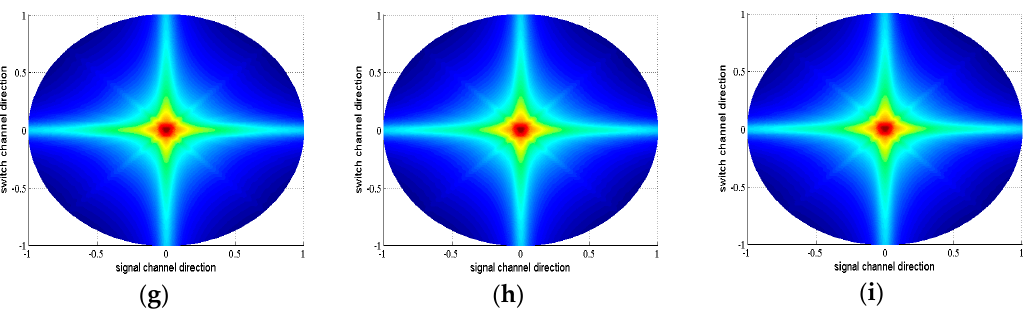
Figure 8. The beamplots of FSA ( a ); RCA ( b ) and best split schemes of SRCA with K from 2 − 8 ( c – i ) for 32 × 32 array.